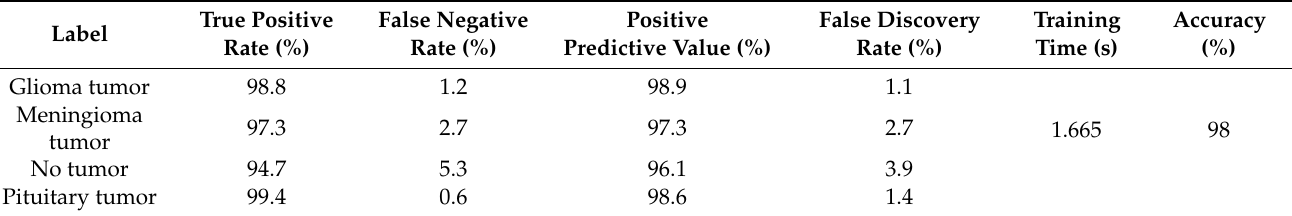
Table 1. Performance of proposed deep-feature-trained SVM